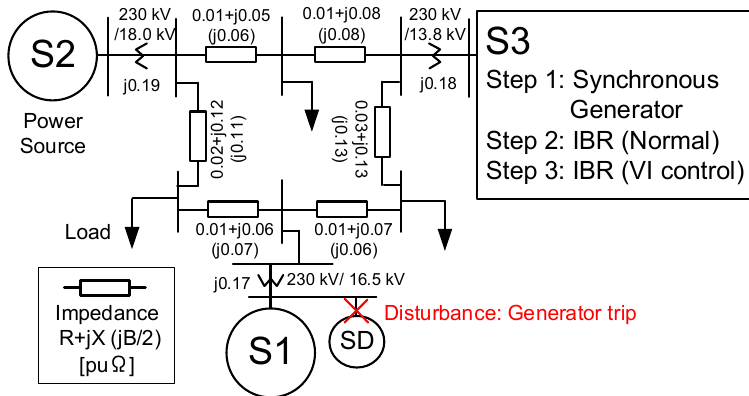
Figure 4. Power system model [31].